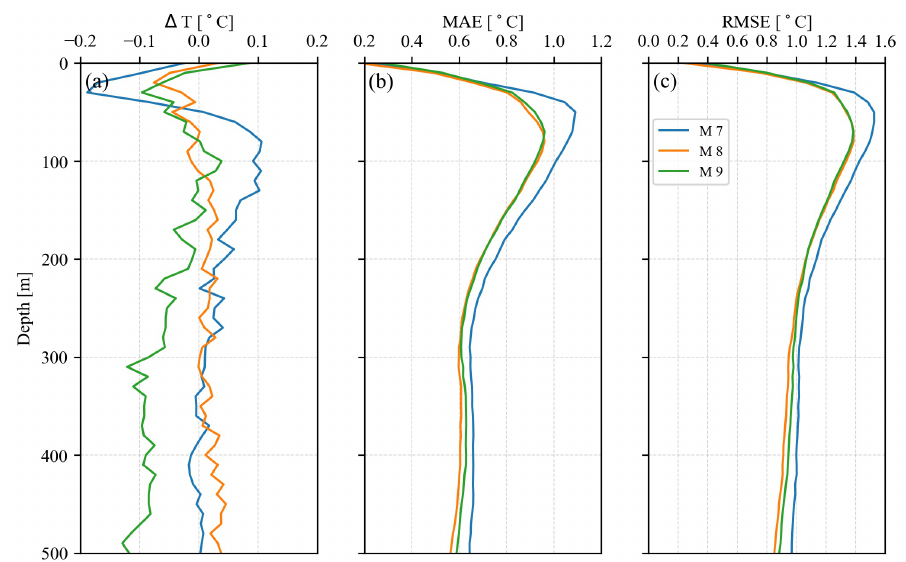
Figure 7. The averaged ( a ) ∆ T , ( c ) RMSE and ( b ) MAE between the Argo-measured and model- predicted temperatures at all depths for model 7/8/9.